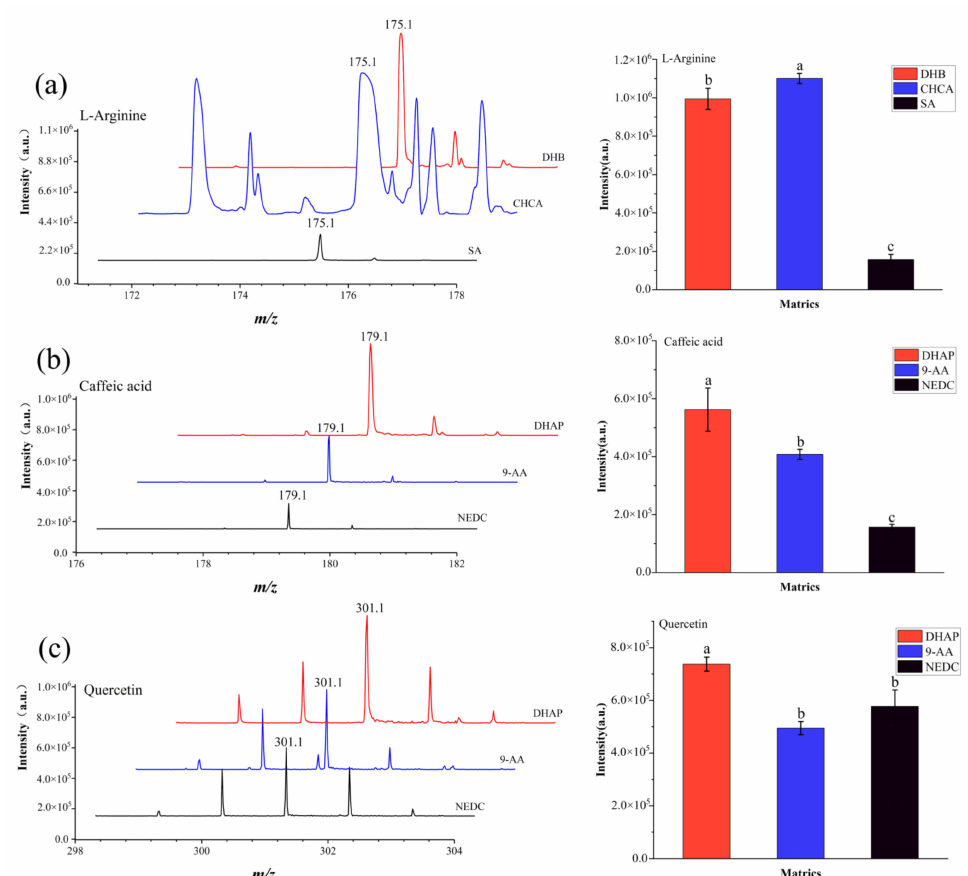
Figure 1. MALDI MS spectra and intensities of representative components using different matrices. MALDI MS spectra and intensities of L-Arginine ( a ) using DHB, CHCA, and SA; MALDI MS spectra and intensities of caffeic acid ( b ), and quercetin ( c ) using DHAP, 9-AA, and NEDC. Different lowercase letters in the histograms indicates significant differences among matrices ( p <